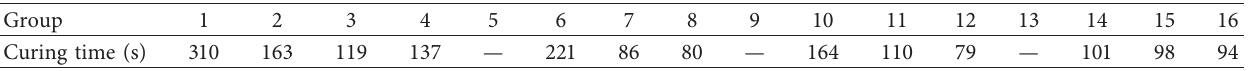
Table 6: Test results of grout curing time.